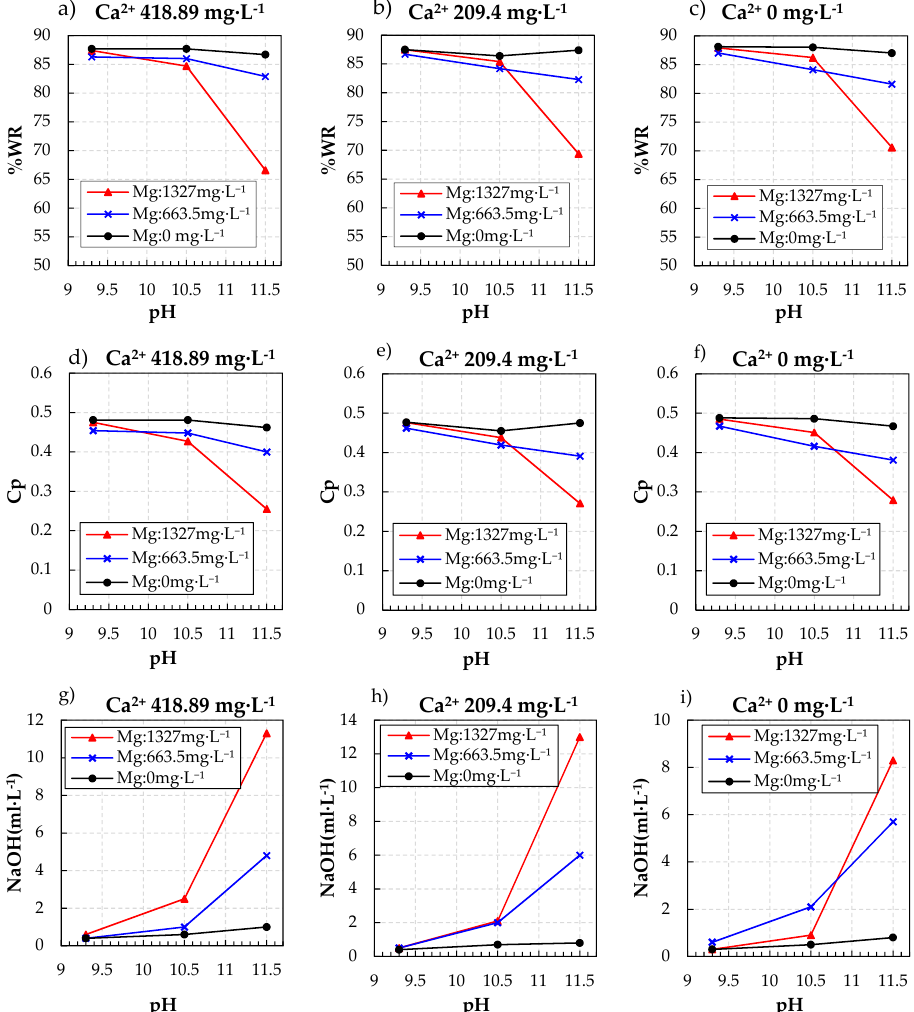
Figure 6. Trends of solid fraction (Cp), water recovery (% WR), and NaOH solution consumption by varying Ca 2+ and Mg 2+ concentrations as well as pH. ( a ) % WR at 418.89 mg·L − 1 of Ca 2+ , ( b ) %WR at 209.4 mg·L − 1 of Ca 2+ , ( c ) %WR at 0 mg·L − 1 of Ca 2+ , ( d ) Cp at 418.89 mg·L − 1 of Ca 2+ , ( e ) Cp at 209.4 mg·L − 1 of Ca 2+ , ( f ) Cp at 0 mg·L − 1 of Ca 2+ , ( g ) NaOH solution consumption at 418.89 mg·L − 1 of Ca 2+ , ( h ) NaOH solution consumption at 209.4 mg·L − 1 of Ca 2+ , ( i ) NaOH solution consumption at 0 mg·L − 1 of Ca 2+ .